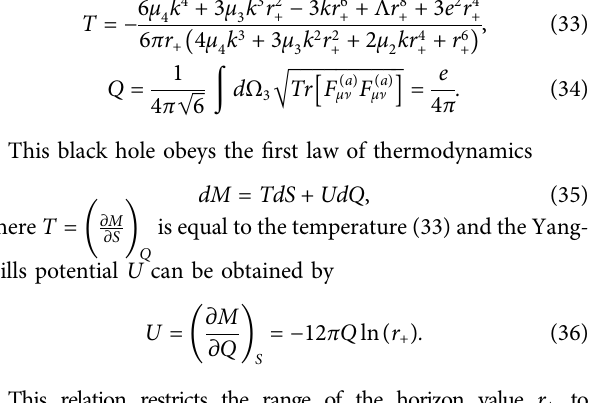
Frontiers in Physics |